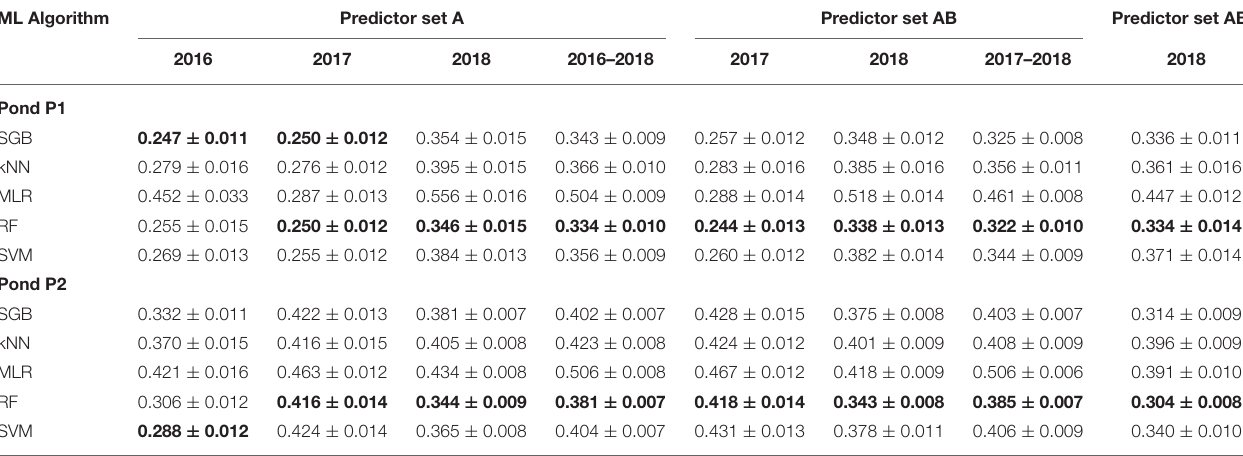
TABLE 1 | Average root-mean-squared errors (RMSE) of logarithms of E. coli concentrations predicted with four machine learning algorithms and multiple linear regression.